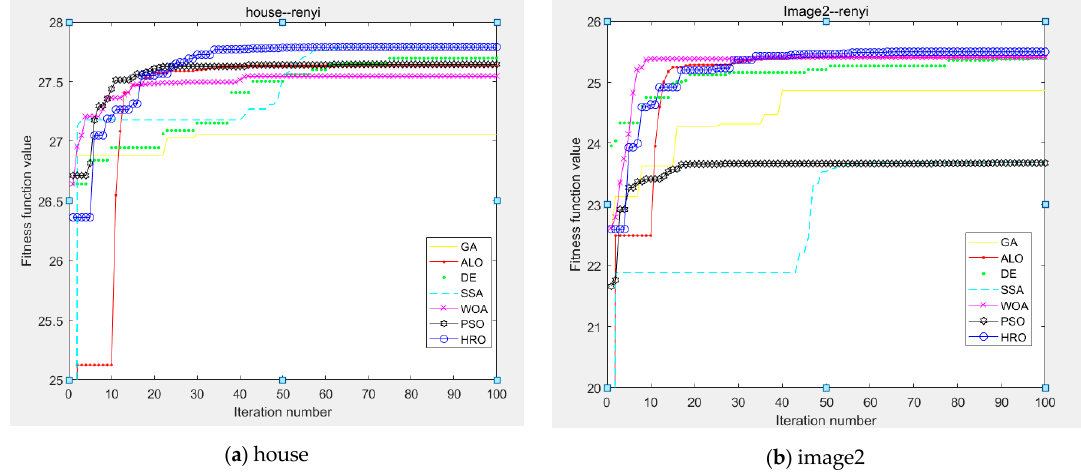
Figure 5. Convergence curve of the maximum fitness functions of each algorithm in Renyi’s entropy.